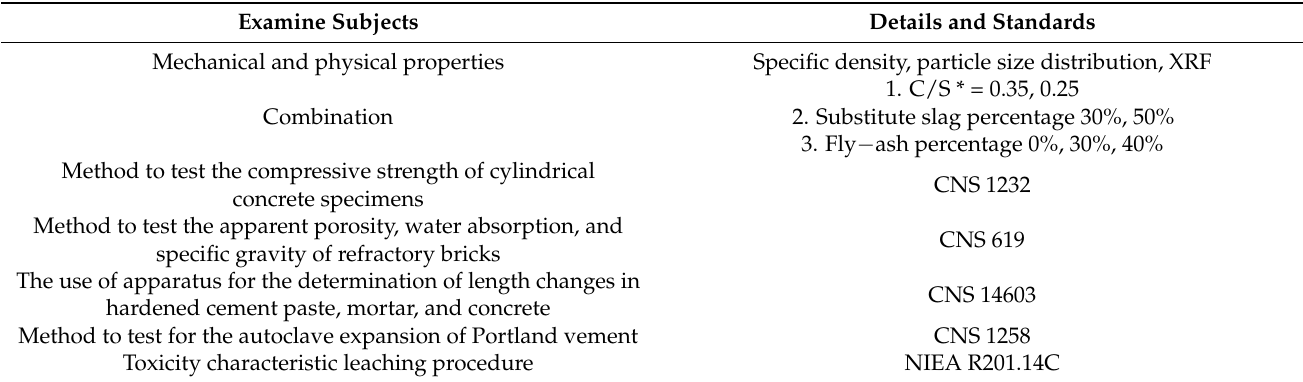
Table 1. Mechanical performance examination.